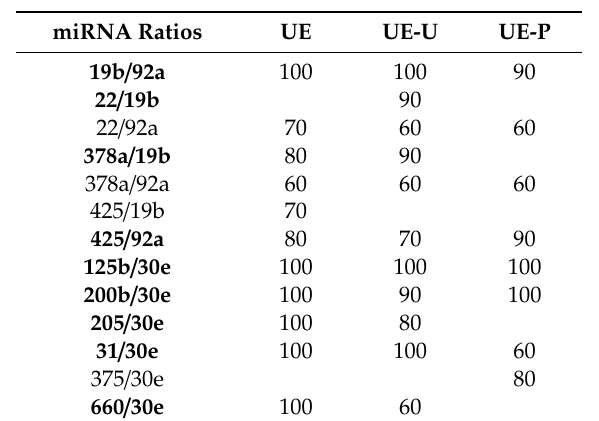
Table 3. Receiving operator characteristic (ROC) curve analysis: PCa vs. (HD + BPH), sensitivity at 100%